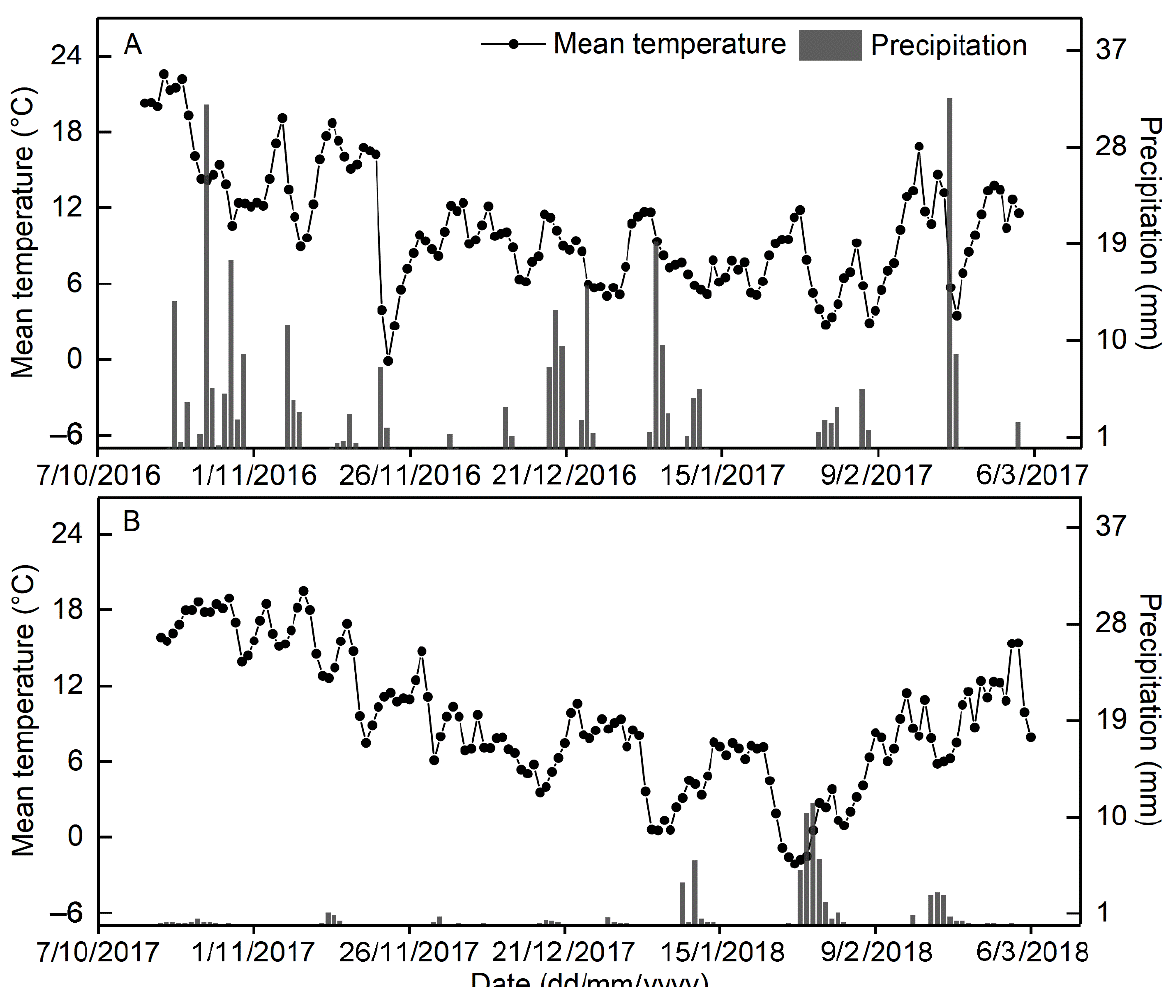
Figure 1. Changes in average daily temperature and rainfall during purple caitai growing seasons in 2016 ( A ) and 2017 ( B ) .